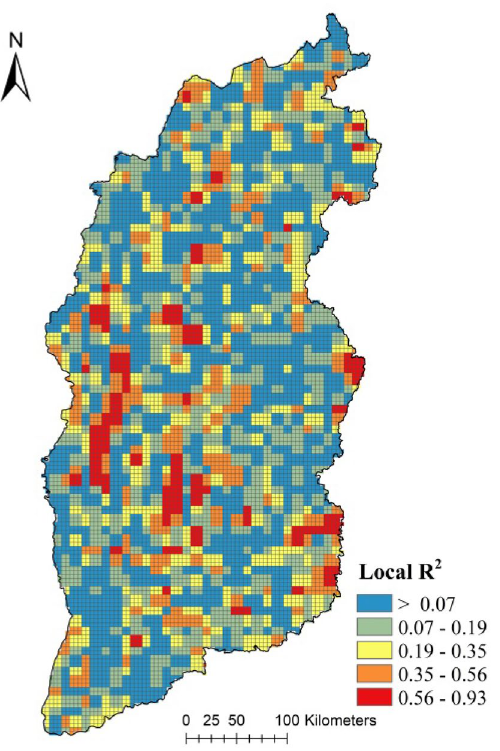
Figure 5. Local R 2 values from the GWR analysis.